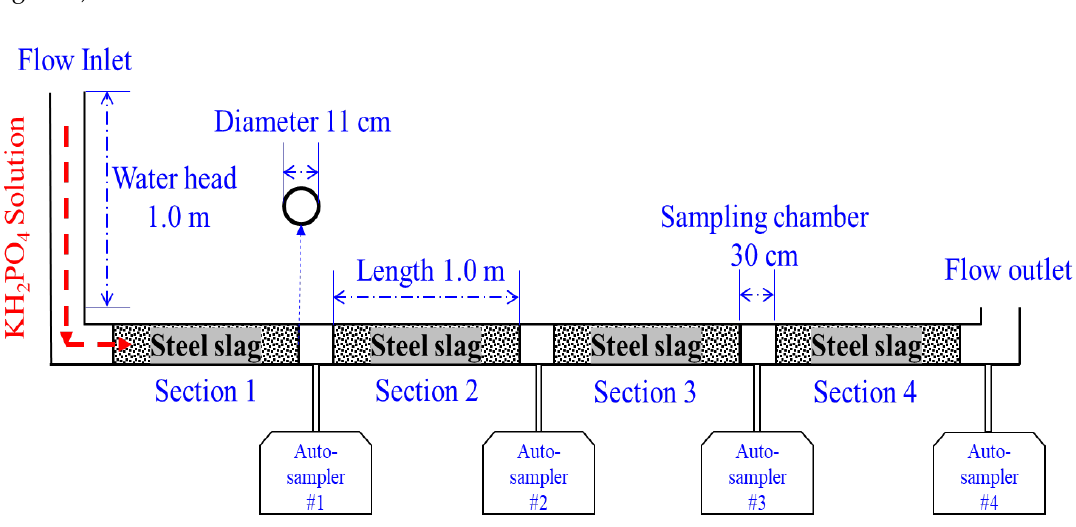
Figure 1. Schematic diagram of the multisegmented flow-through equipment in this